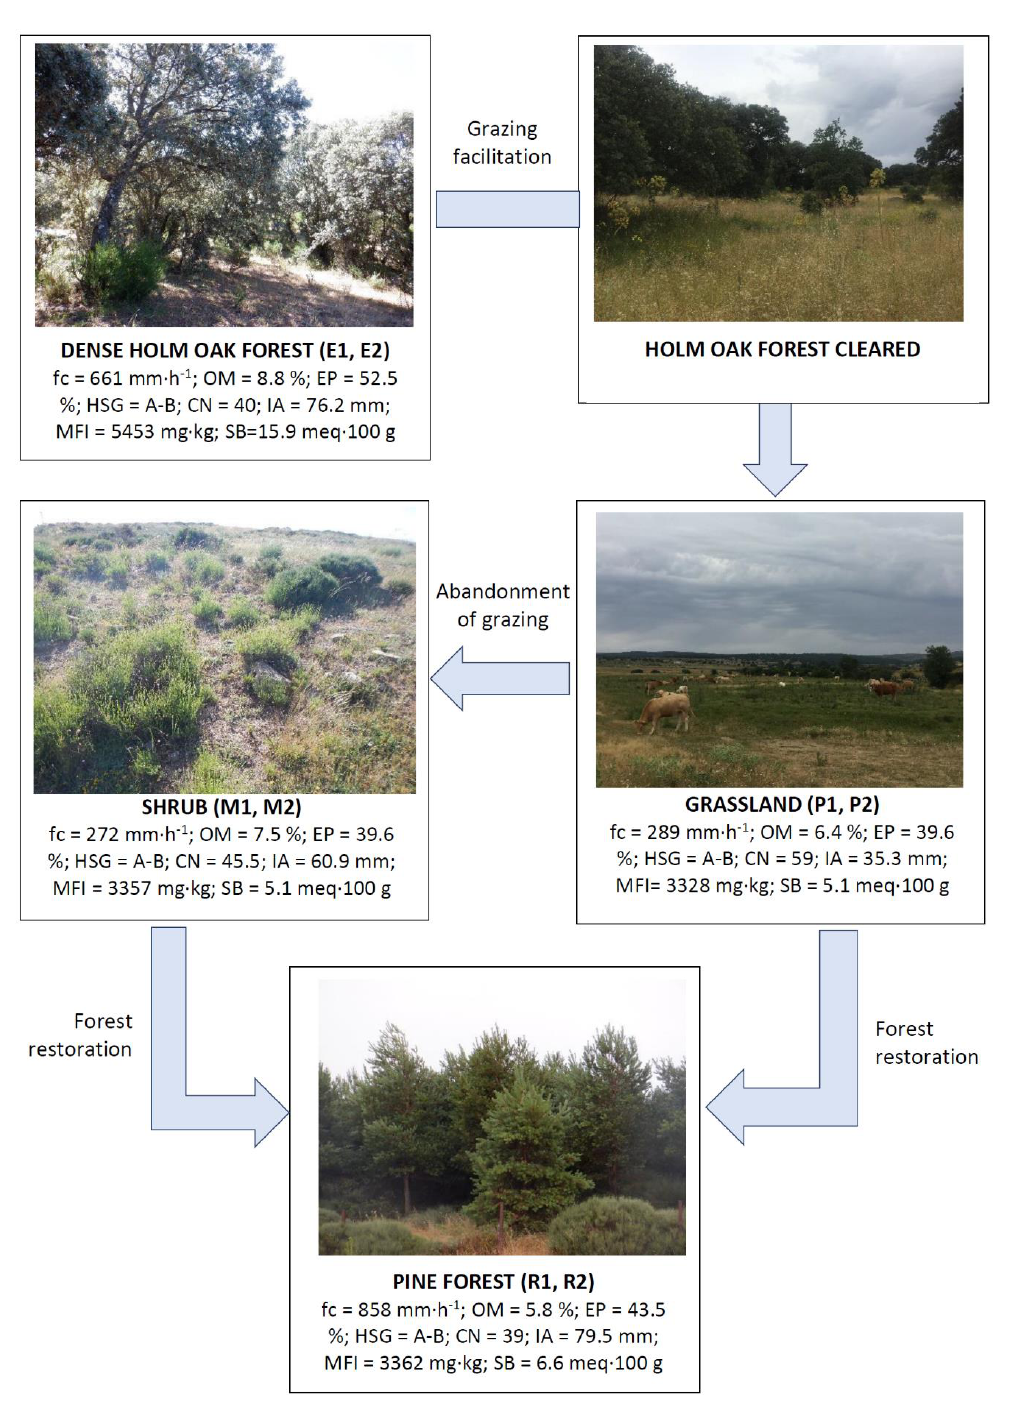
Figure 10. Diagram of anthropic evolution of the vegetation in the study area. The original dense holm oak forest would be cleared for livestock, becoming a grassland without trees. This grassland could become a shrub area if grazing were abandoned. Both grasslands and shrubs could be forested, generating pinewood. At the same time, there would be changes in the edaphic and hydrological parameters of the soil. Abbreviations: fC = steady-state infiltration rate; HGS = hydrologic soil group; CN = curve number; IA = initial abstraction; EP = effective porosity; OM = organic matter; MFI = macrofertility index; SB = sum of